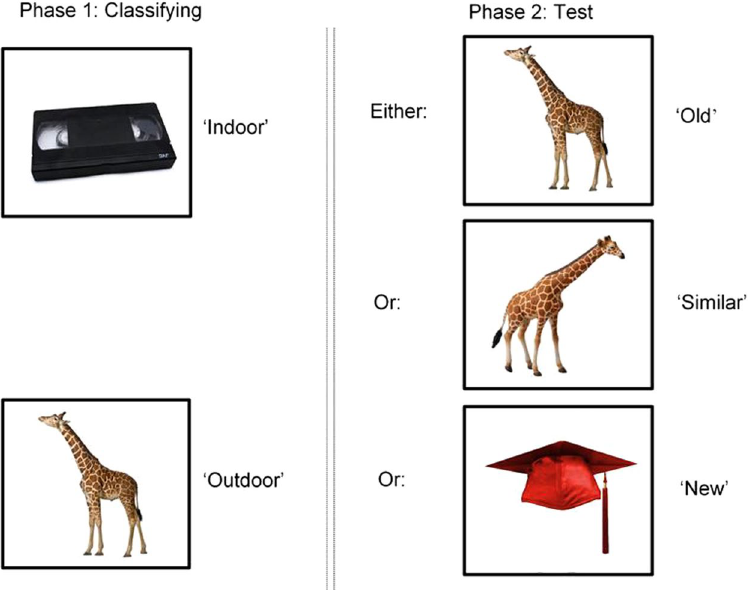
Figure 1. Phase one and two of the MST. Phase one involved classifying objects as either ‘indoor’ or ‘outdoor’. Phase two followed immediately after, and assessed participant’s memory for the objects they had seen in phase one by presenting either the object again (target), a perceptually similar but not identical object (lure), or a completely new object (foil). Only one of these three categories were presented; for example, the target was not presented again if the similar object had already been presented. Figure produced with author permission from Stark et al . 14 . Images accessed at